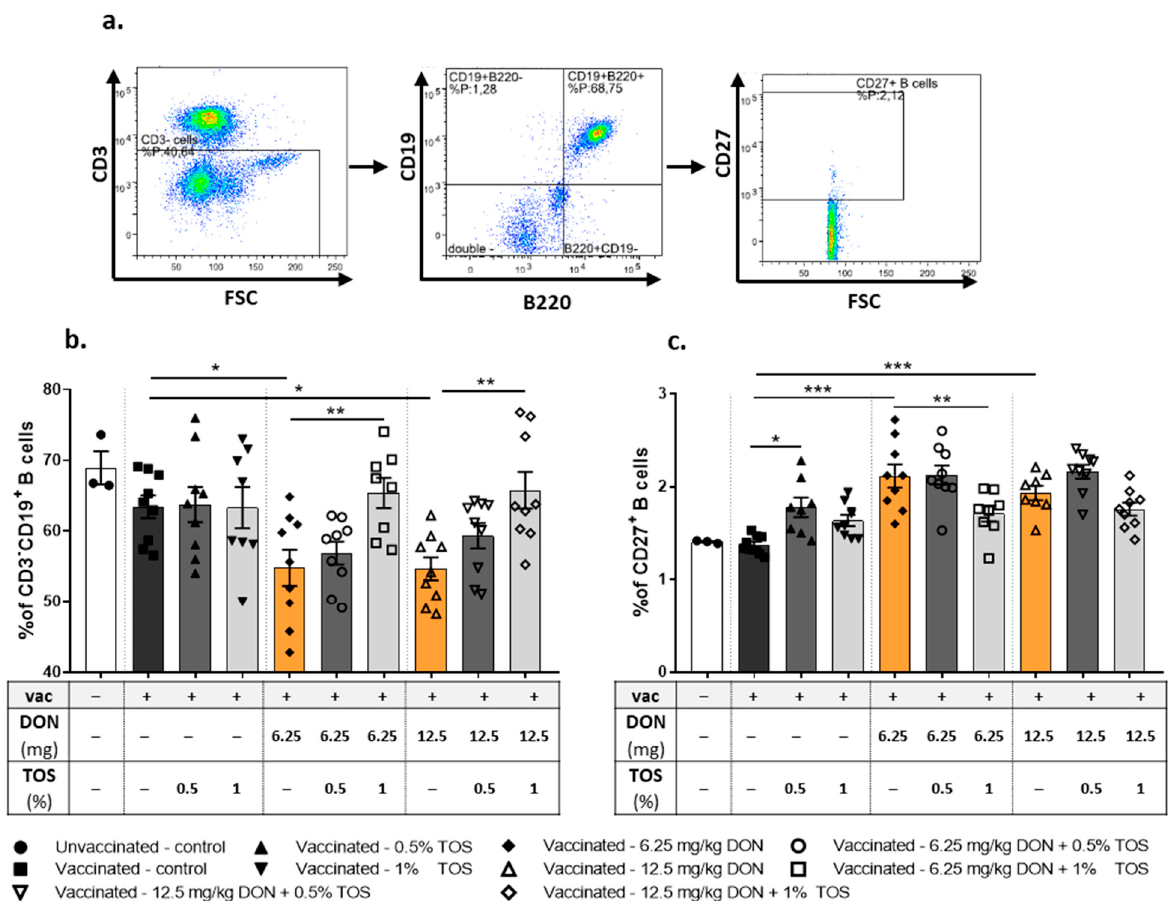
Figure 5. Flow cytometric analysis of B cell subpopulations in spleen of vaccinated (vac +) and unvaccinated (vac − ) mice fed on diets containing deoxynivalenol (DON) and/or trans-galacto-oligosaccharides (TOS). Gating strategy ( a ), percentage of CD19 + B220 + B-cells ( b ) and CD27 + memory B cells ( c ). Data are presented as mean ± SEM. * p < 0.05, ** p < 0.01 and *** p < 0.001 indicate statistical differences.